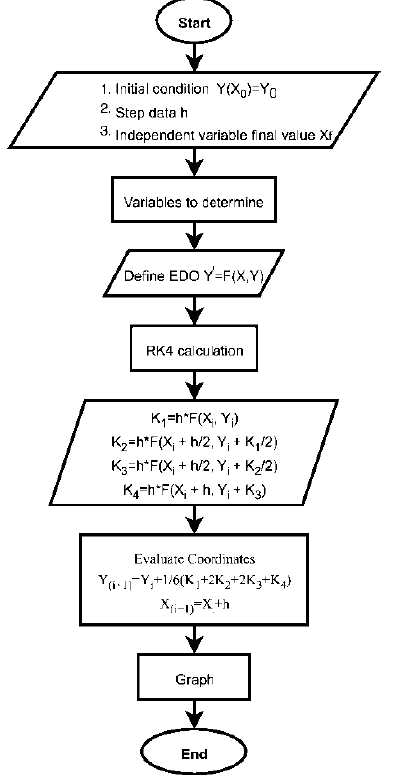
Figure 4. Flow chart of the Runge – Kutta 4th order method in MATLAB ® .